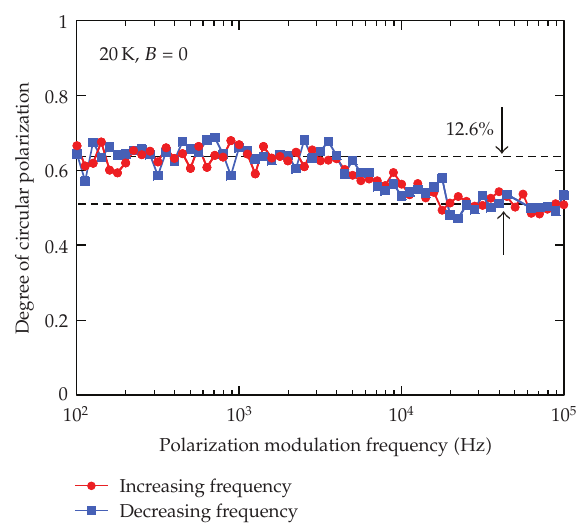
Figure 8: Polarization modulation frequency dependence of the DCP in X (cid:9) line. The e ff ect of the DNP on stabilizing the spin state was limited and estimated to be ∼ 13% in terms of DCP.